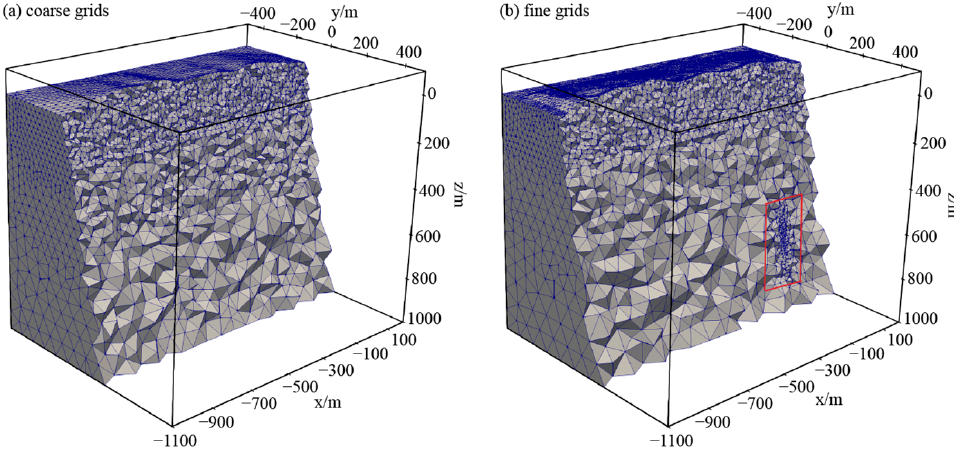
Figure 13. Meshes for our dual-mesh inversion of survey data from Daye, China.